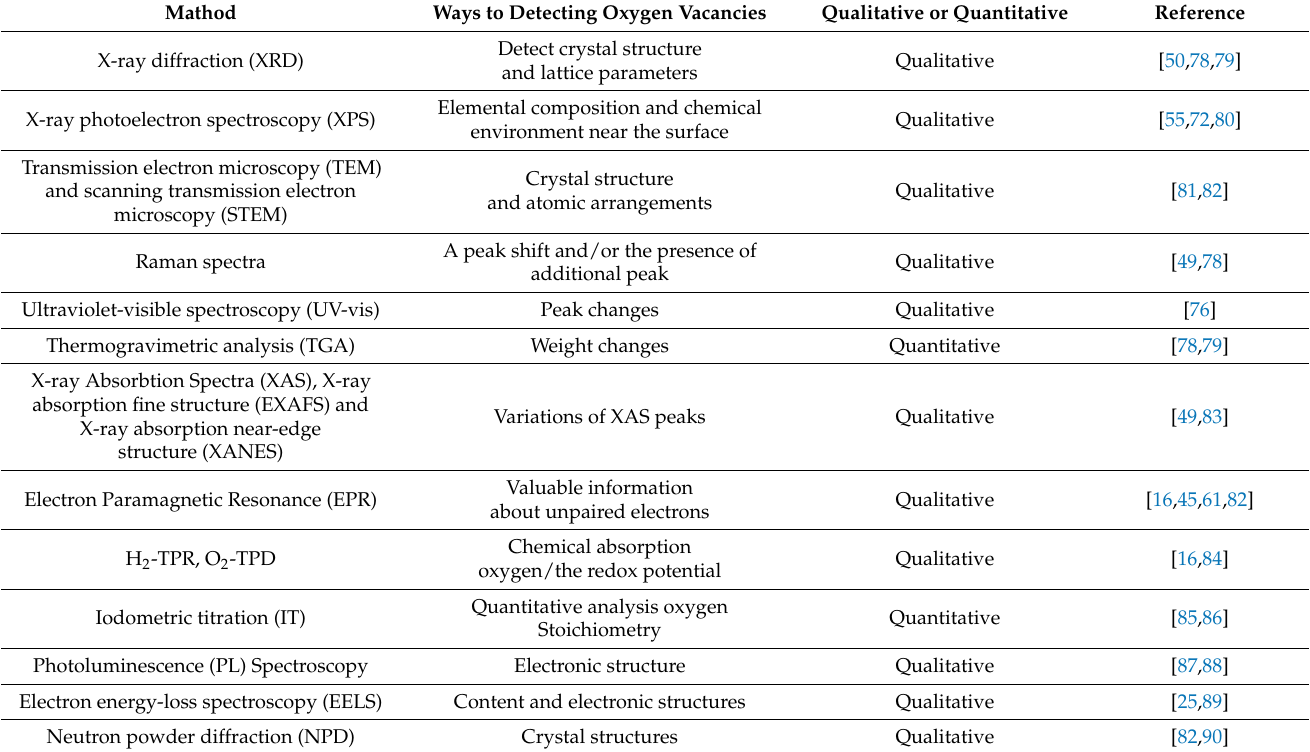
Table 3. Summary of technologies for detecting oxygen vacancies in